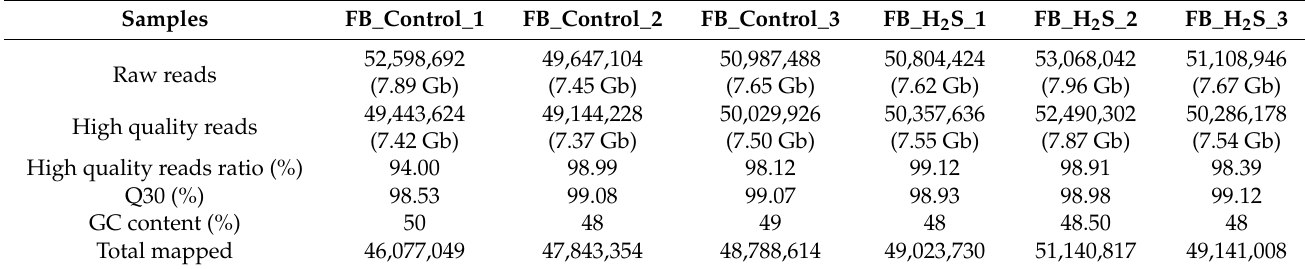
Table 1. The sequencing data of samples.